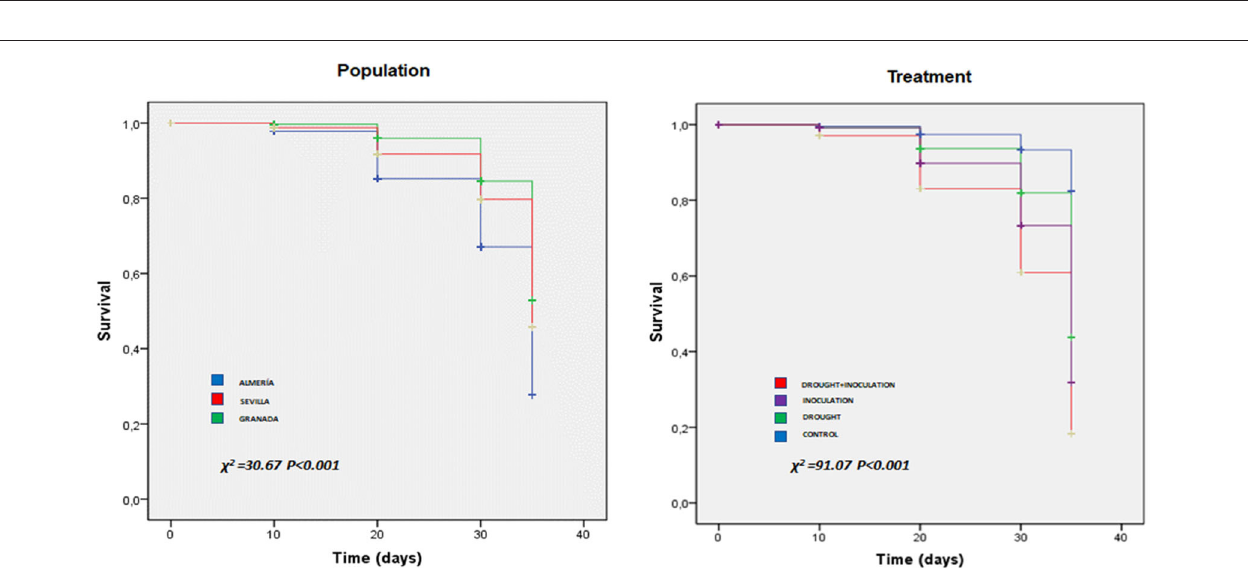
FIGURE 2 | Survival plots for the three Q. ilex populations (Almeria, Granada, and Seville) under the individual and combined effects of inoculation with P. cinnamomi and drought as determined with the Kaplan–Meier model. The units of the x - and y -axis are days and seedling survival rate,